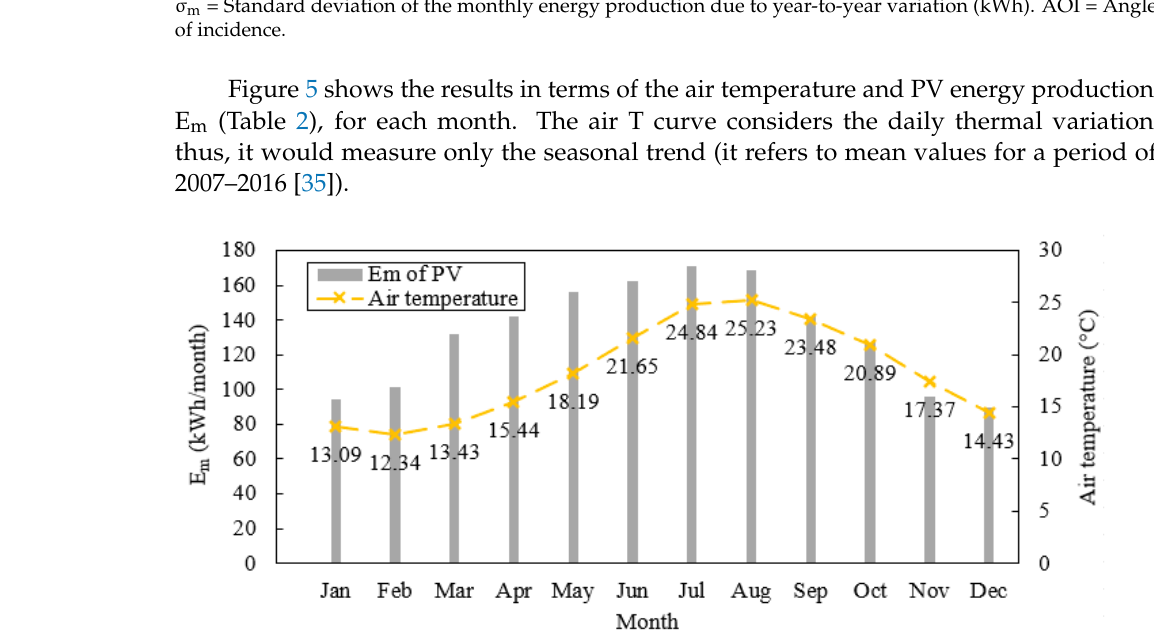
Figure 5. Air temperature curve and mean energy, E m , of PV histograms [35] (adapted from [12]).